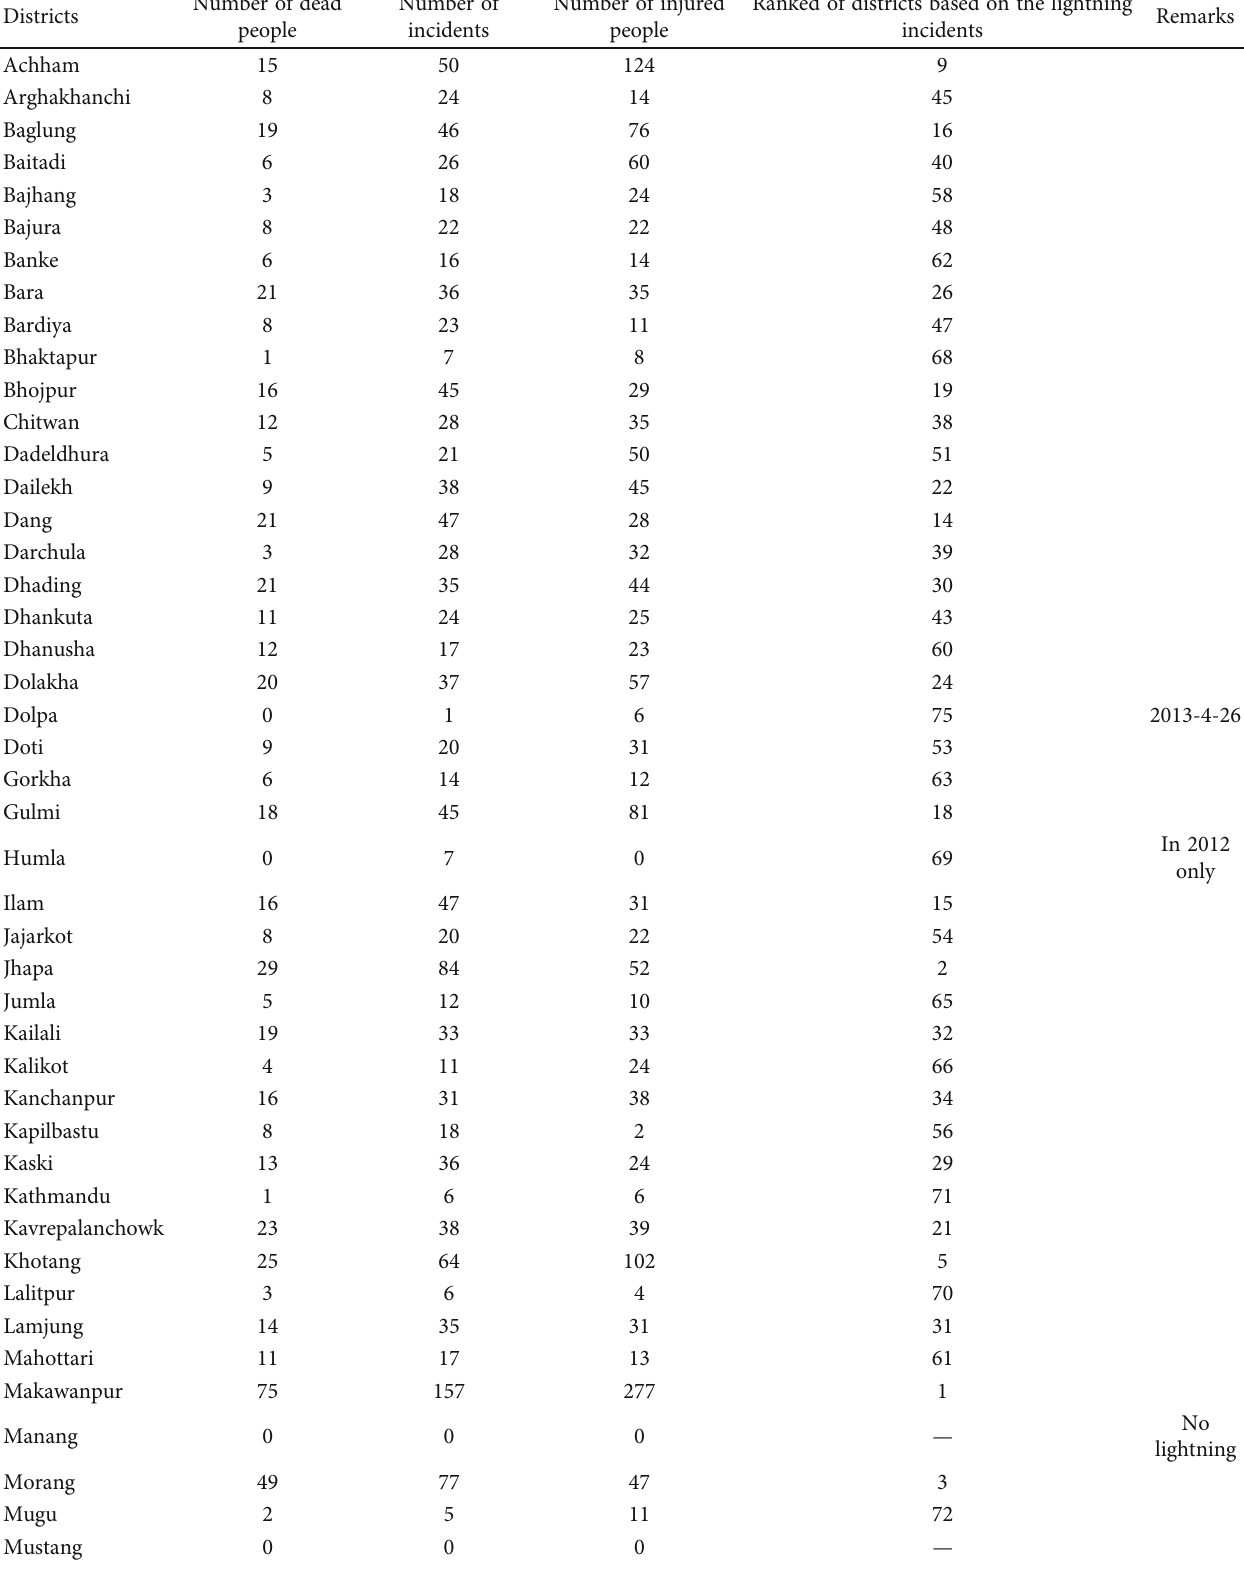
Table 4: The distribution of the lightning phenomena and severe thunderstorms over the seventy-seven districts of Nepal during the period of January 2011 to December